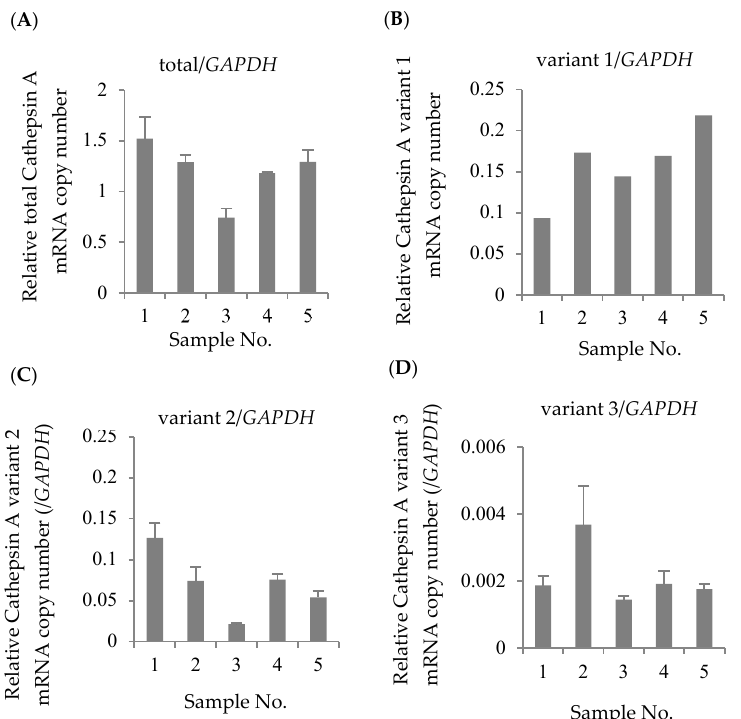
Figure 2. Absolute expression levels in Cathepsin A mRNA in Japanese lymphocytes. The copy numbers of total Cathepsin A variants ( A ), variant 1 ( B ), variant 2 ( C ), and variant 3 ( D ) were measured by real-time RT-PCR and were normalized by the copy number of GAPDH . The data represented as the mean ±